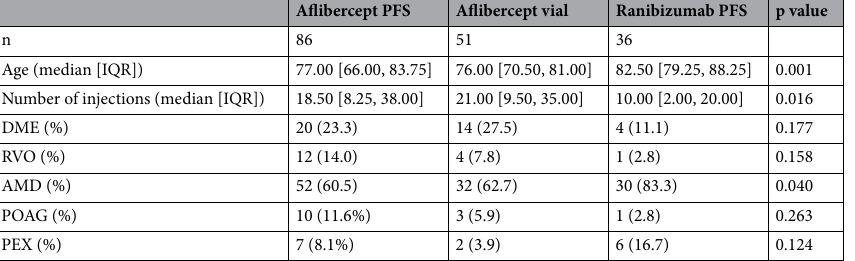
Table 1. Clinical characteristics with treated pathologies in the three patient groups injected with intravitreous anti-VEGF drugs. The p value describes differences between the three groups in general. Only the median age was significantly higher in the ranibizumab PFS group than both aflibercept groups. All other charactreistics did not significantly differ within the three groups. AMD age-related macular degeneration, DME diabetic macular edema, IQR interquartile range, POAG primary open angle glaucoma, PEX pseudoexfoliation syndrome, PFS prefilled syringe, RVO retinal vascular occlusion.